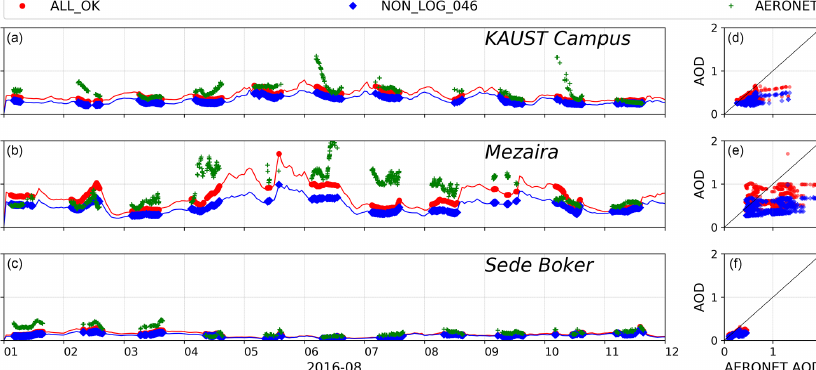
Figure 3. AOD time series (a–c) and scatter plots (d–f) from NON_LOG_046 and ALL_OK runs (blue and red lines) and AERONET AOD (green markers) at KAUST Campus, Mezaira, and Sede Boker. WRF-Chem’s AOD is interpolated to the times (blue diamonds and red dots) when AERONET AOD measurements were conducted.